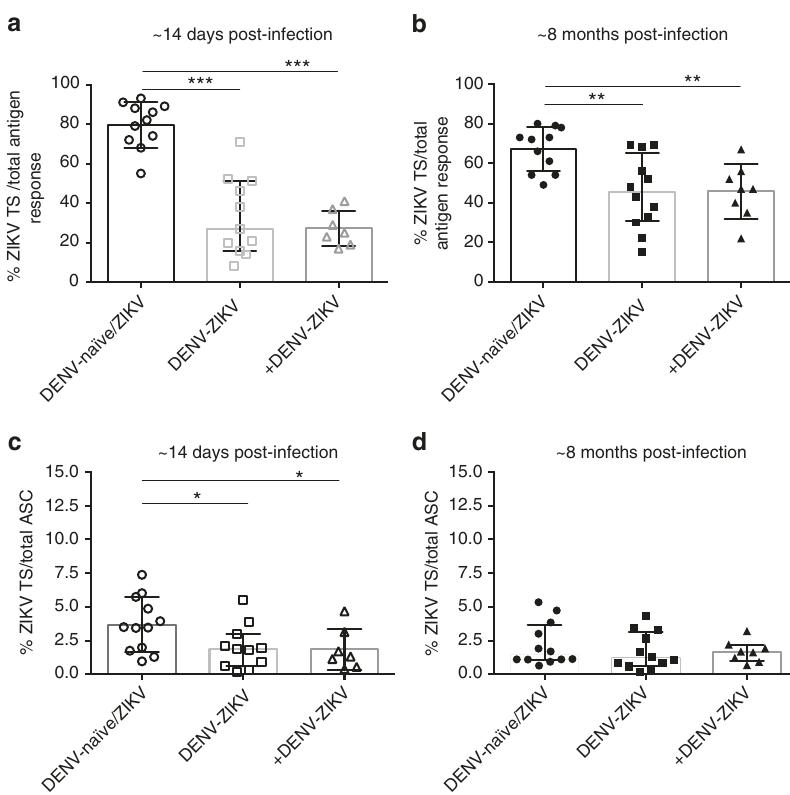
Fig. 2 ZIKV type-speci fi c MBC response is maintained over time in ZIKV + patients. ZIKV type-speci fi c MBC cell responses in ZIKV-infected patients with no (DENV-naïve/ZIKV), one (DENV-ZIKV), or more than one ( + DENV-ZIKV) prior DENV infection. a , b ZIKV type-speci fi c IgG-secreting MBC response over total antigen response at ~14 days ( a ) and ~8 months ( b ) postinfection. c , d ZIKV type-speci fi c IgG-secreting MBC response over total ASC response at ~14 days ( c ) and ~8 months ( d ) postinfection. The median and interquartile range (IQR) are shown for all graphs. Signi fi cance was determined by Kruskal – Wallis test and Dunn ’ s test; * p < 0.05, ** p < 0.01, *** p < 0.001. DENV-naïve/ZIKV, n = 11; DENV-ZIKV, n = 12; + DENV-ZIKV, n = 7 at ~14